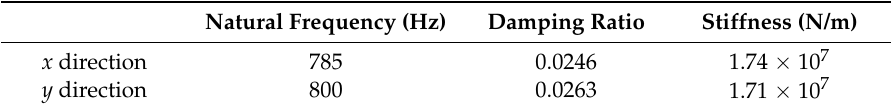
Table 2. The first-order modal parameters.